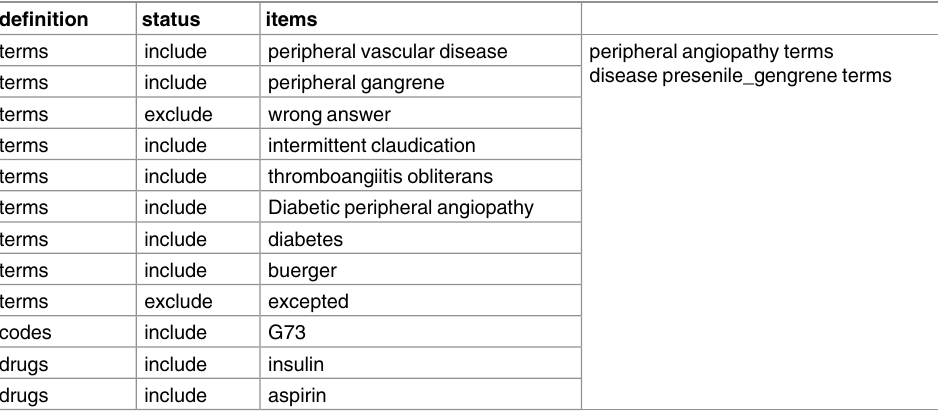
Table 2. Example code list definition in csv